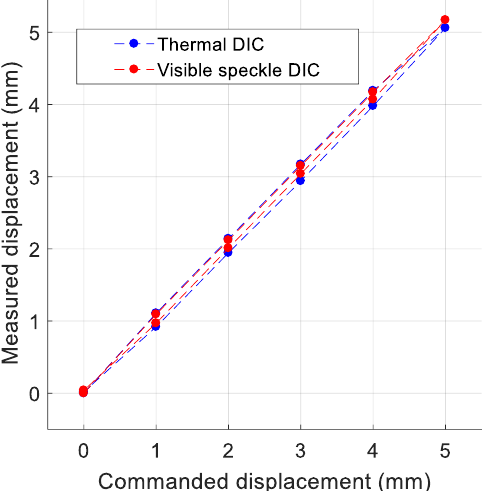
Figure 5. Comparative of displacement measured by employing thermal speckle (blue) and traditional sprayed speckle (red).